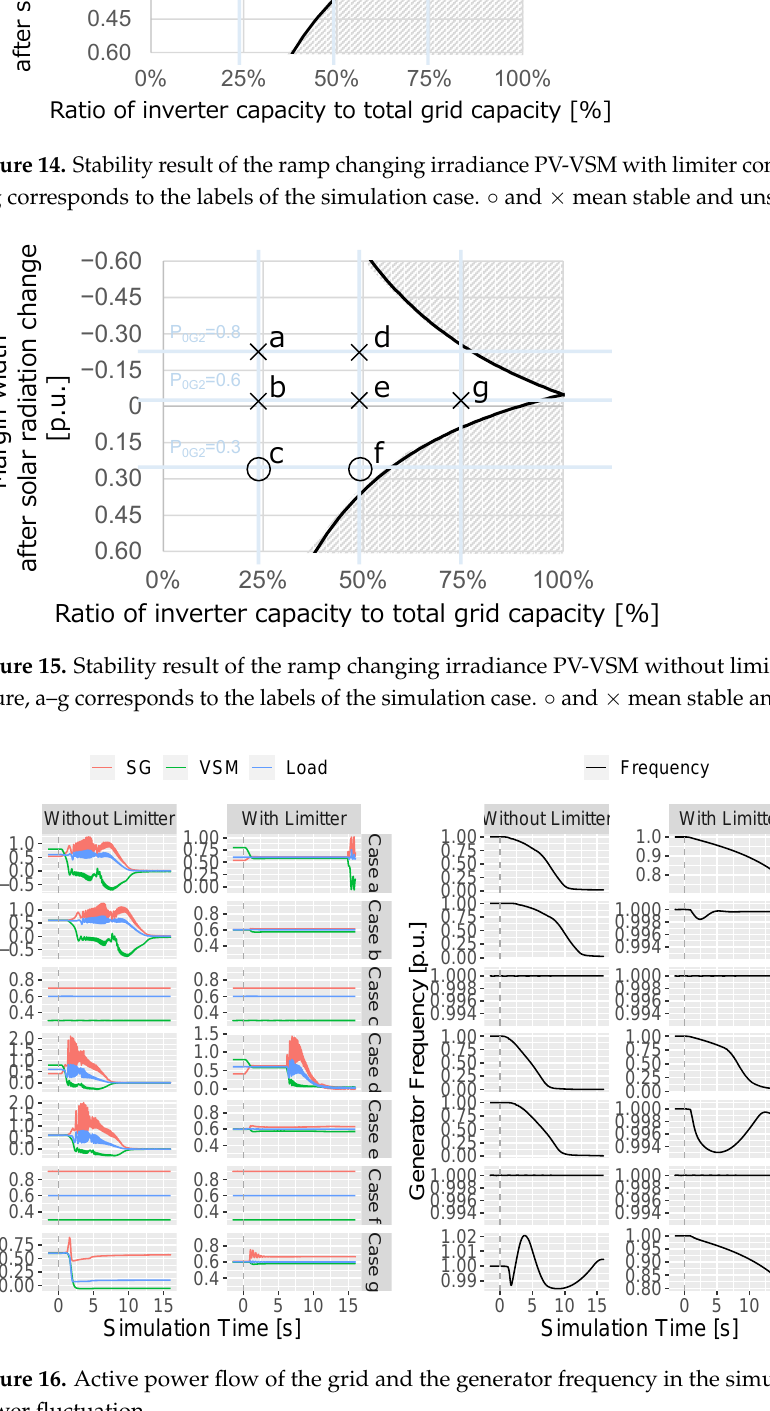
Figure 16. Active power flow of the grid and the generator frequency in the simulation of the solar power